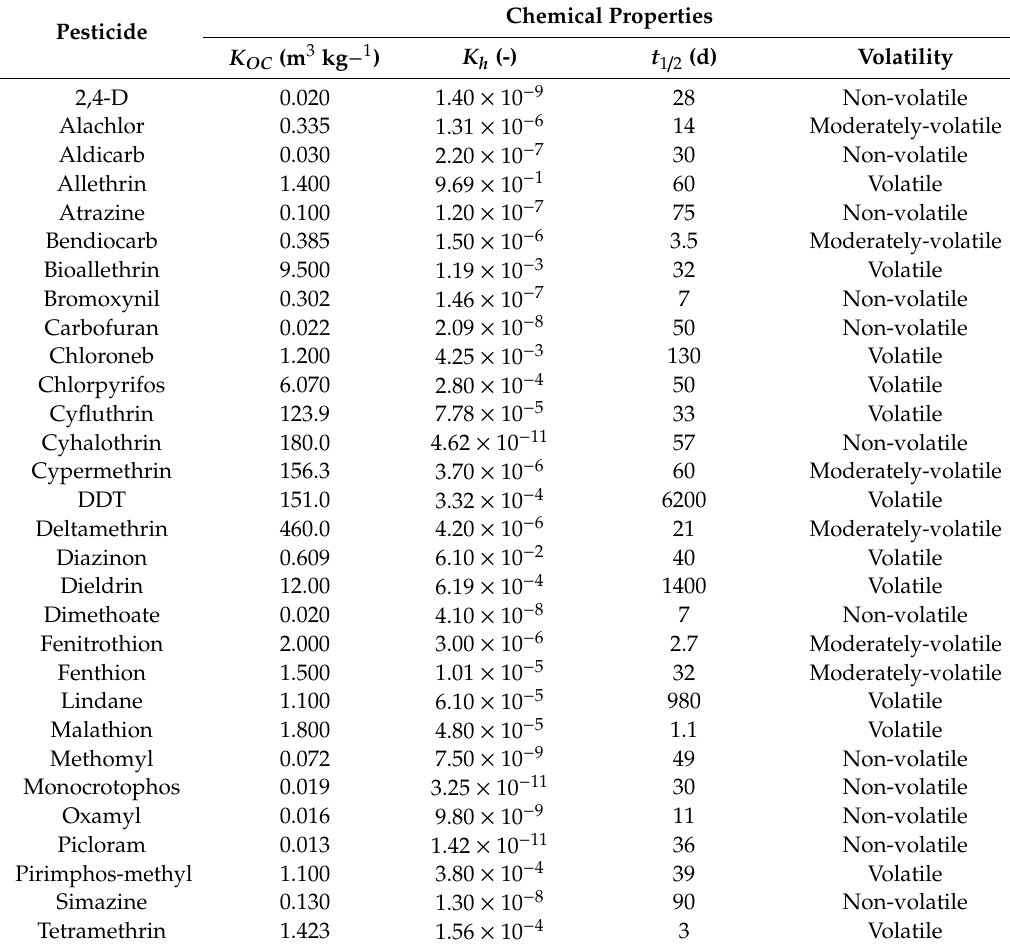
Table 1. Chemical properties of selected